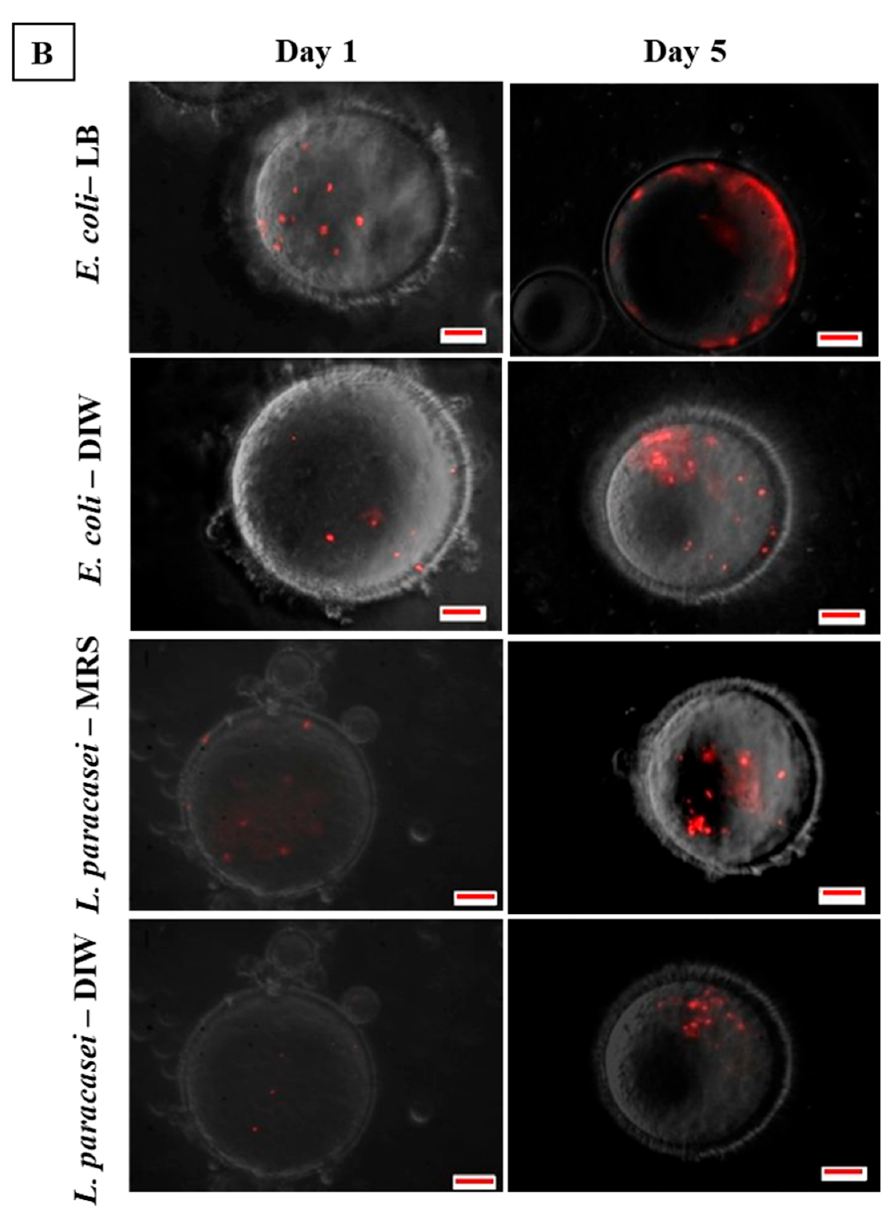
Figure 4. Photomicrographs of bacterial cells encapsulated in W/O droplets during storage showing ( A ) live cells and ( B ) dead cells. Bacterial clusters were observed during storage for samples encapsu- lated with nutrient. Presence of dead cells were also observed after one day of storage for all samples of bacteria encapsulated with or without nutrient. Colour coding—Green: Live E. coli cells, yellow: Live L. paracasei cells and red: Dead cells. Scale bar: 10 μ m .